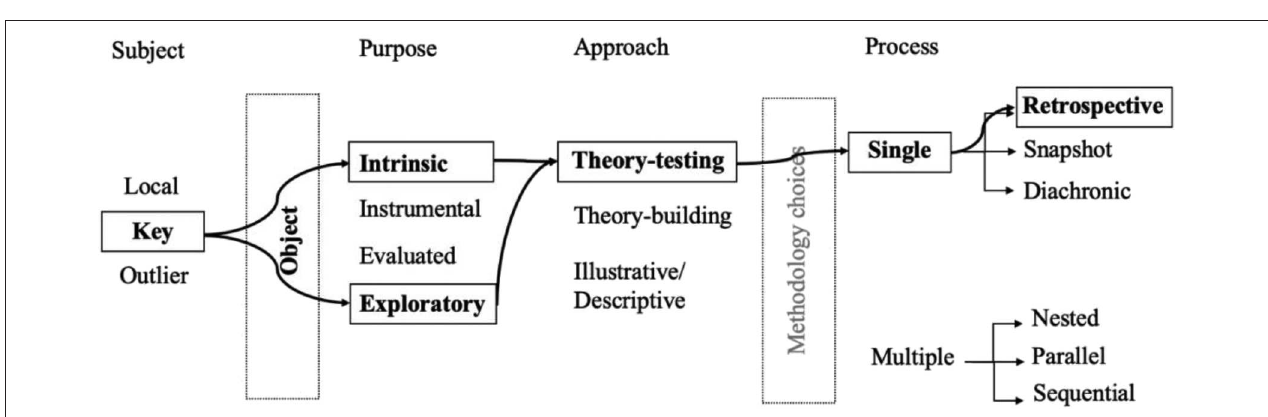
FIGURE 3 | Case study of cost transformation in a peer-to-peer insurance platform. This diagram is adapted from the design framework of Thomas